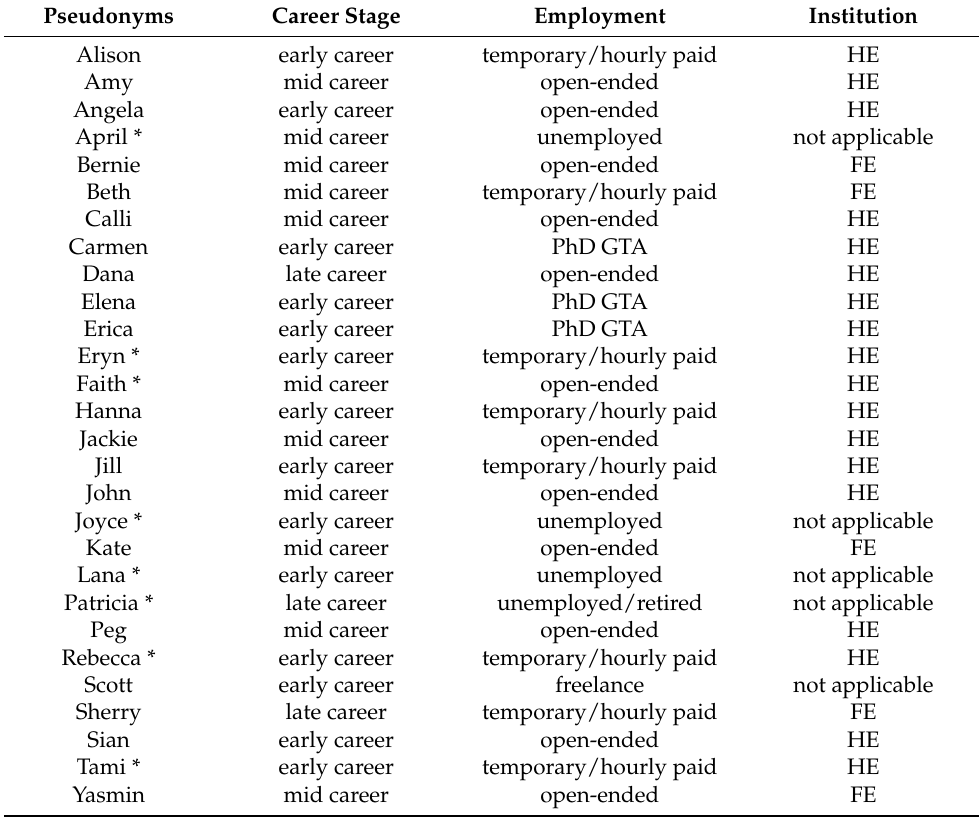
Table 1. Summary of participants’ career